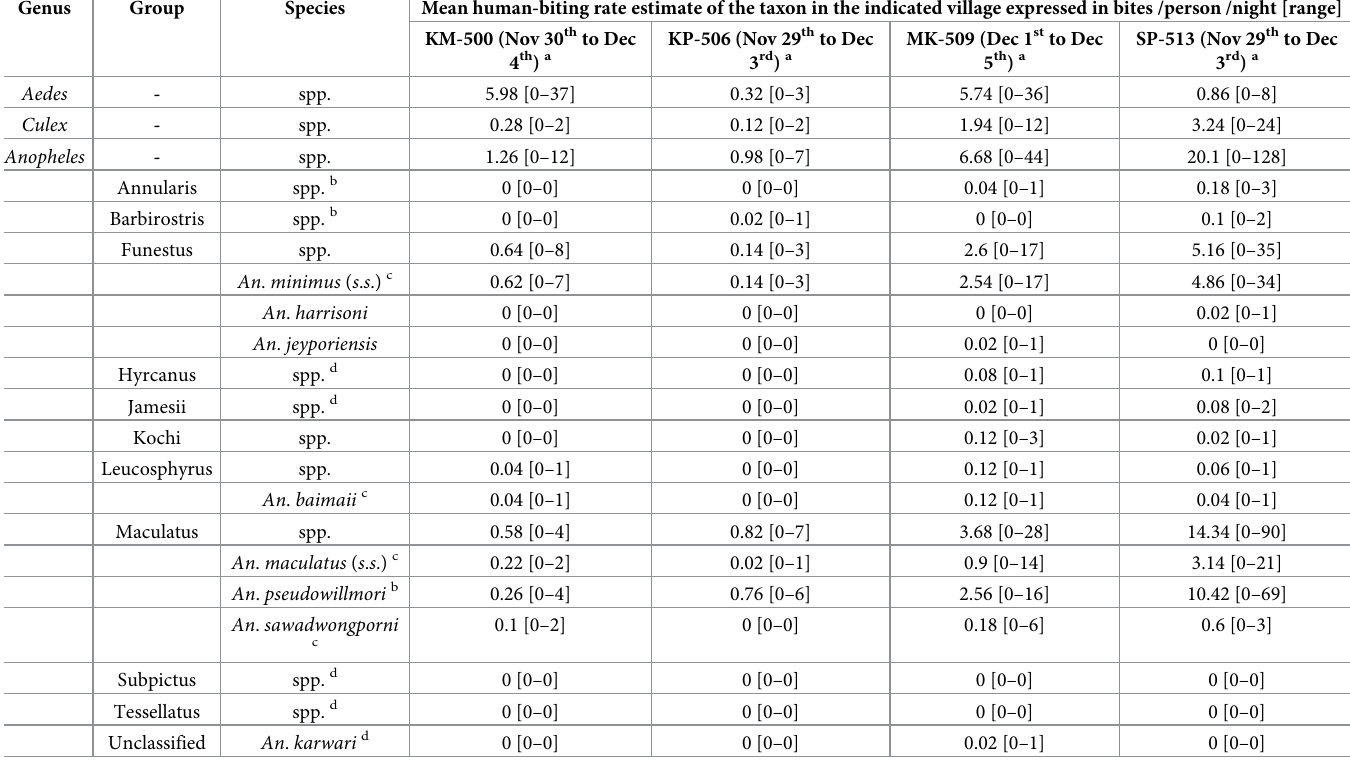
Table 1. Village-collated mean estimates of mosquito human-biting rates determined during baseline surveys.